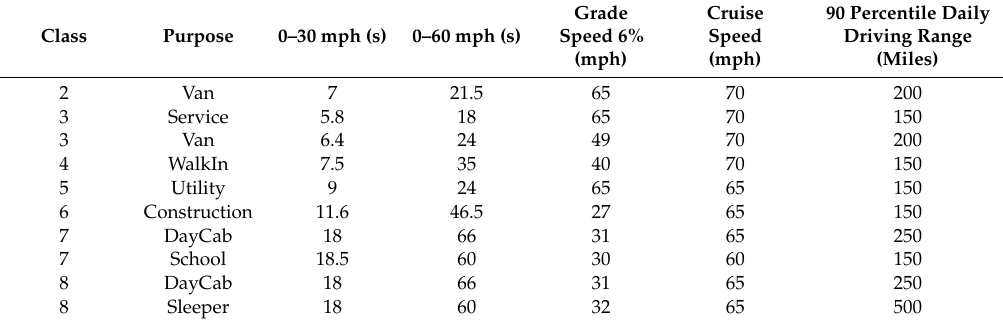
Table 2. Performance summary for all vehicles considered in this